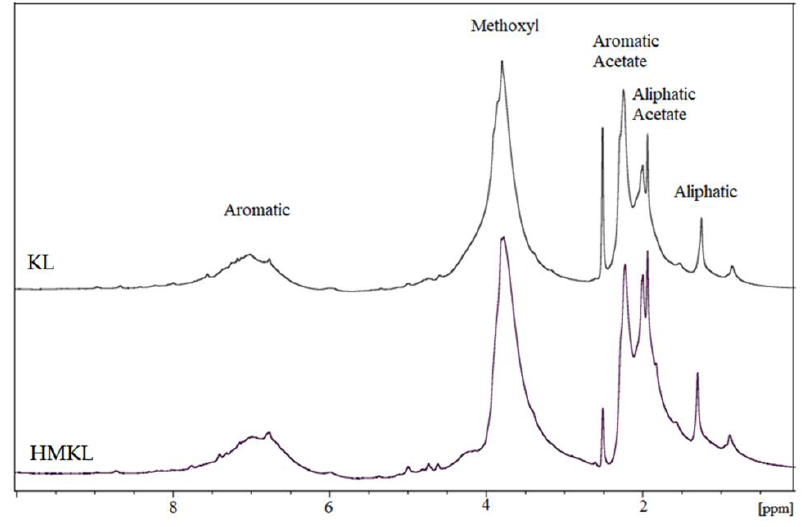
Figure 3. 1 H Nuclear magnetic resonance (NMR) spectra of unmodified KL and HMKL.